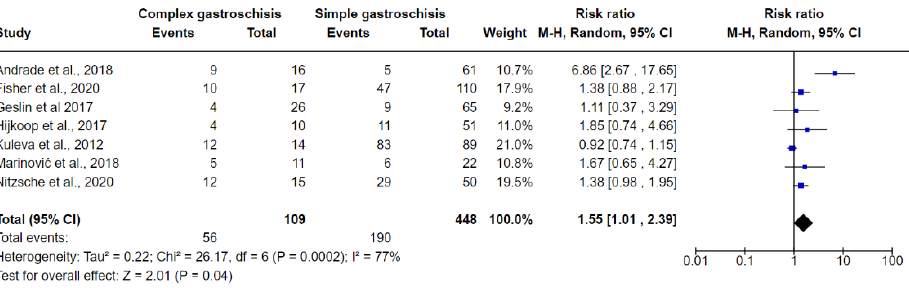
Figure 7. Forest plot between simple and complex gastroschisis for EABD ultrasound Figure 6. Forest plot between simple and complex gastroschisis for IABD ultrasound markers.